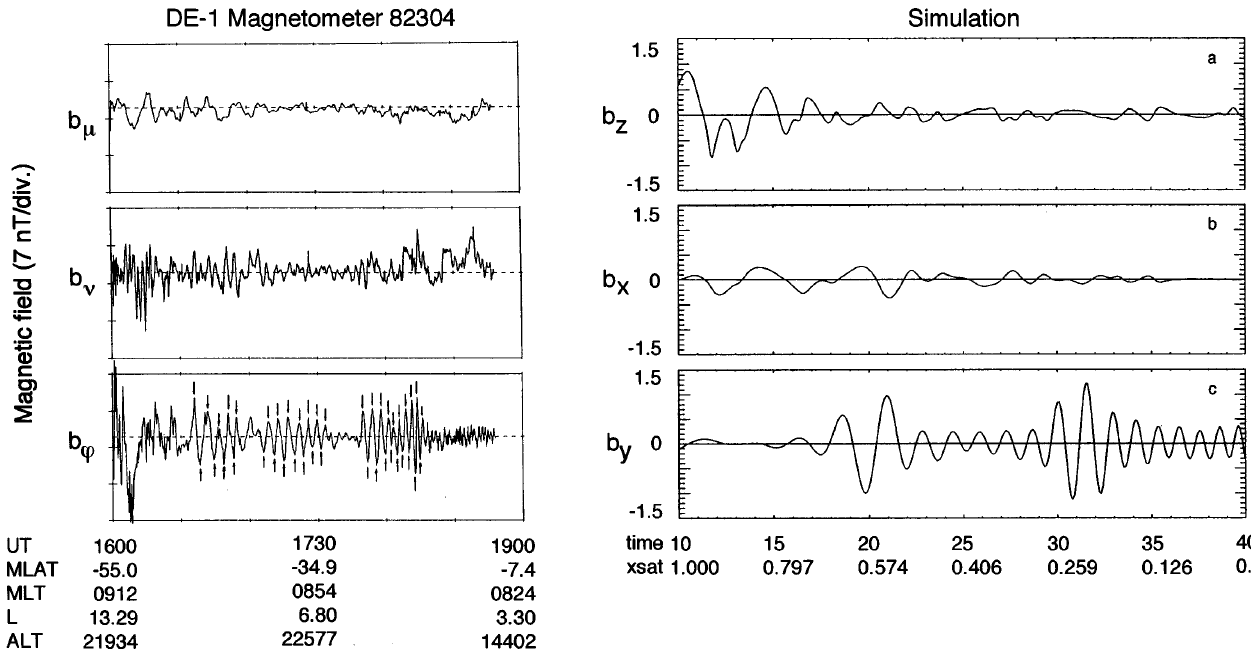
Fig. 9. Comparison of magnetic field time series from a satellite ( left , adapted from Fig. 3b of Lin et al ., 1992) and a wave guide simulation ( right , adapted from Fig. 9 of Rickard and Wright, 1995). The field components from top to bottom are field-aligned, radial, and azimuthal